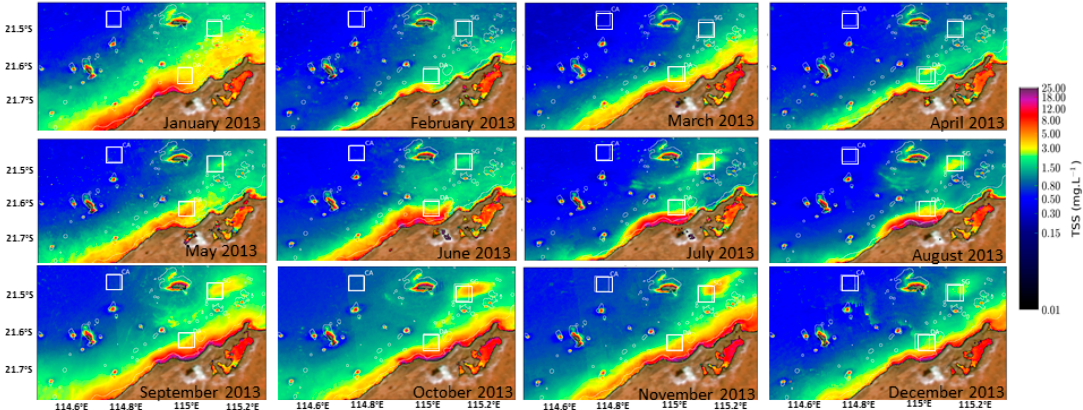
Figure 9. 2013 monthly averaged TSS images derived from MODIS-Aqua 250 m band 1 (January to December 2013). Rectangles represent locations for CA, DA, and SG.